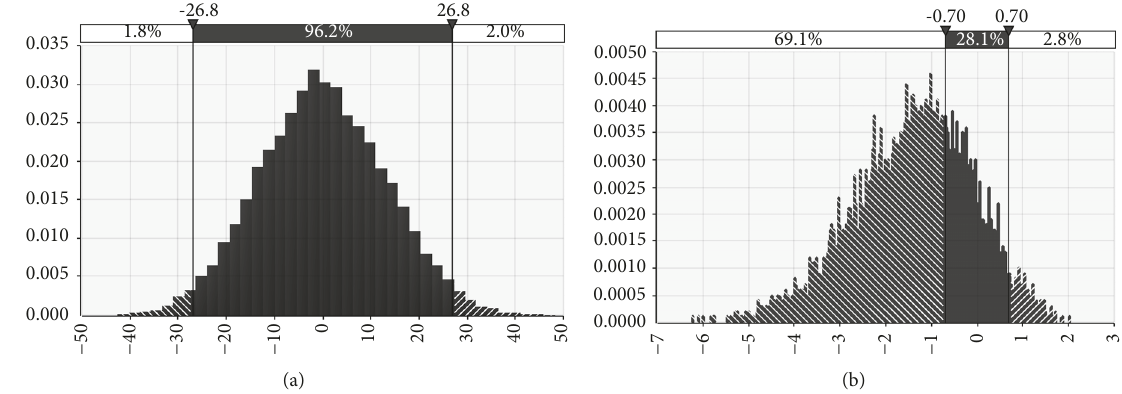
Figure 7: Relative frequency histograms showing the accuracy probability of the forecast produced by the techniques. (a) Histogram of cost accuracy in month 40 for the Santiago project. (b) Histogram of duration accuracy in month 10 for the Mazar Dudas project.